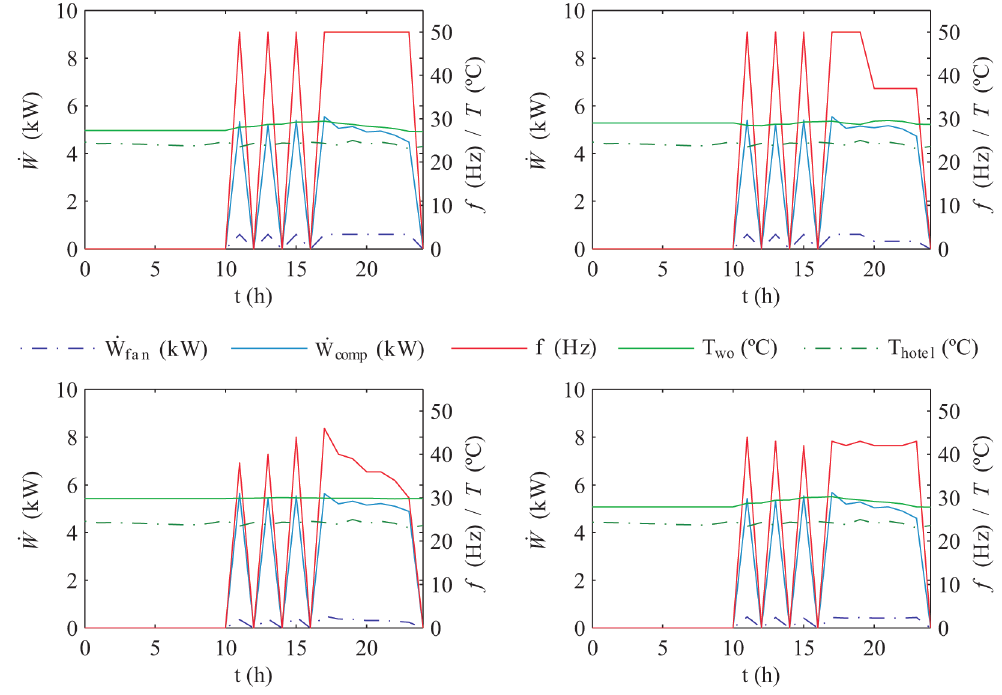
Figure 9. Behavior of the capacity control methods (FCC, MSC, FMC and OC from left to right and top to bottom) during a day, regarding the power consumption (fan and compressor), the frequency of the fan and the outlet water temperature of the cooling tower and the temperature of the hotel.